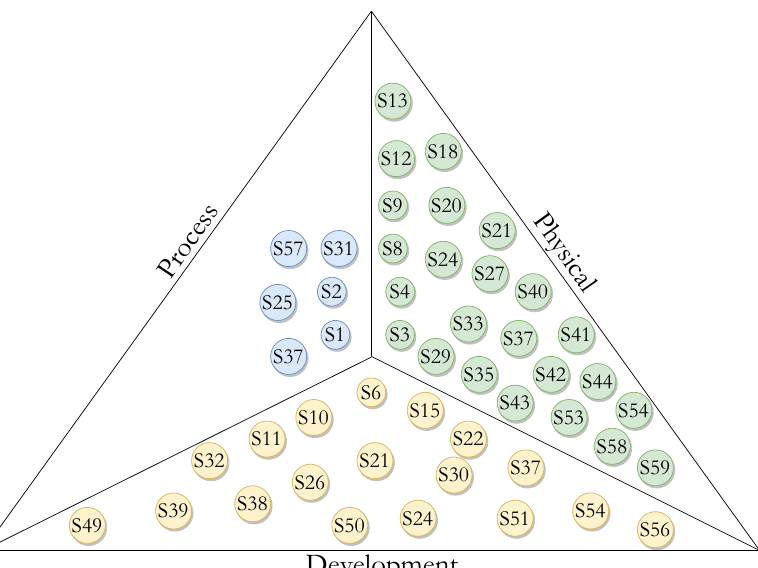
Figure 5. Distribution of primary studies concerning barriers. Blue circles correspond to process, green to physical, and yellow to development.